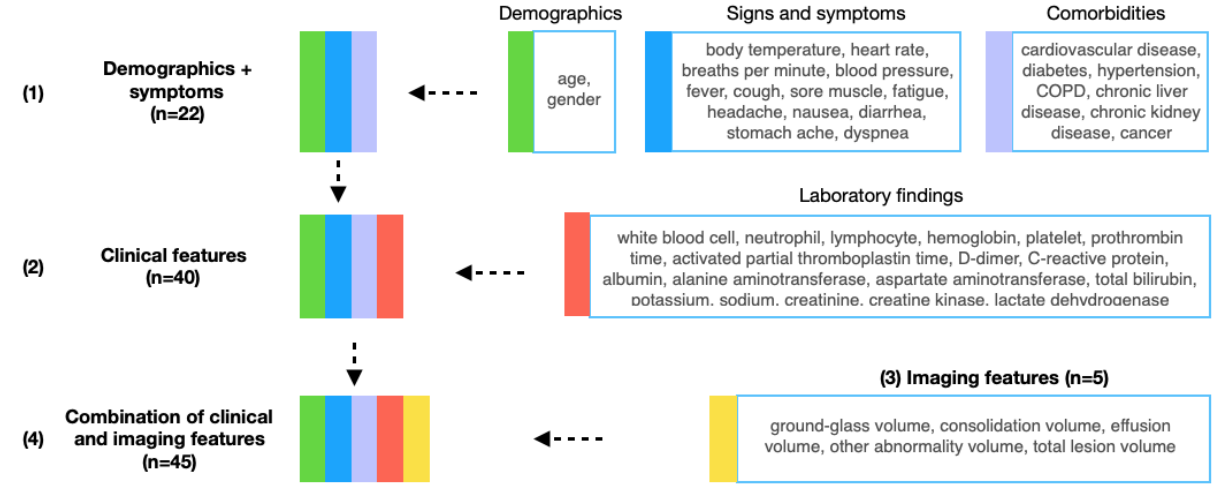
Figure 2. Structure and dimensions of the feature sets. COPD: chronic obstructive pulmonary